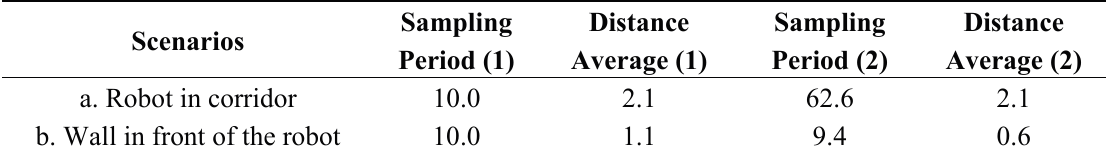
Table 2. Experimental results for the two obstacles tested (average